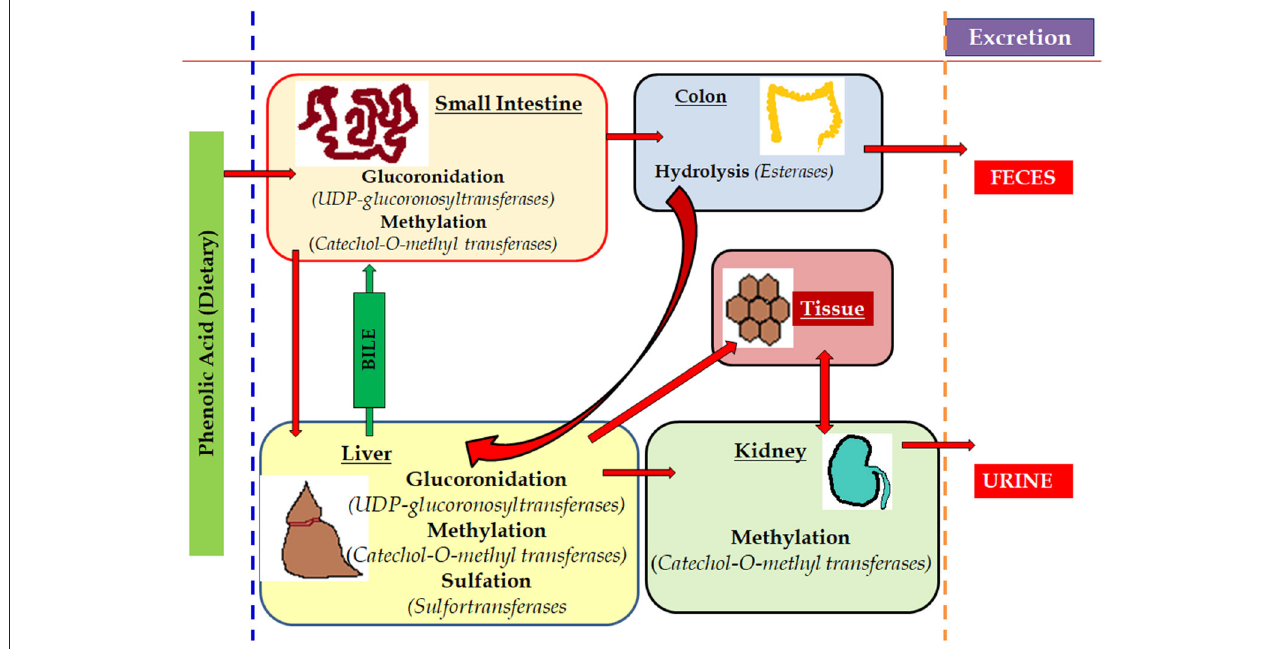
FIGURE 7 | Metabolism of phenols in the living system. The metabolism of the dietary components rich in phenols is easily absorbed by various part of the animal body where the small intestine process and deviates the potent part to hepatic cells and remains are hydrolysed in colon and excreted via feces. Simultaneously, a part of it is methylated in kidney through liver and the last remains are excreted through urination. The red arrows mark is used to show the various route of metabolism of